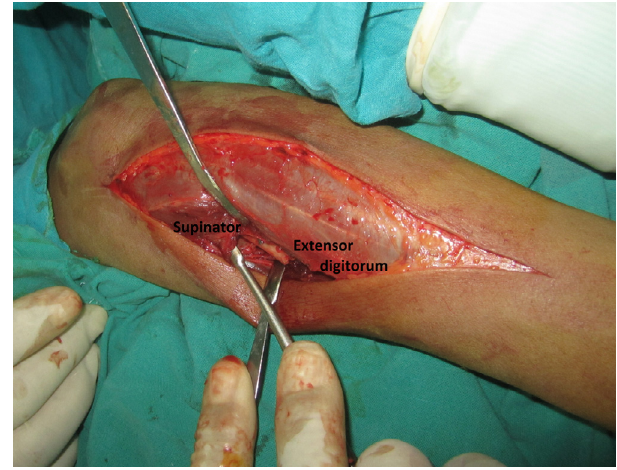
Figure 4. An intraoperative photograph demonstrating subperios- teal retraction of the supinator